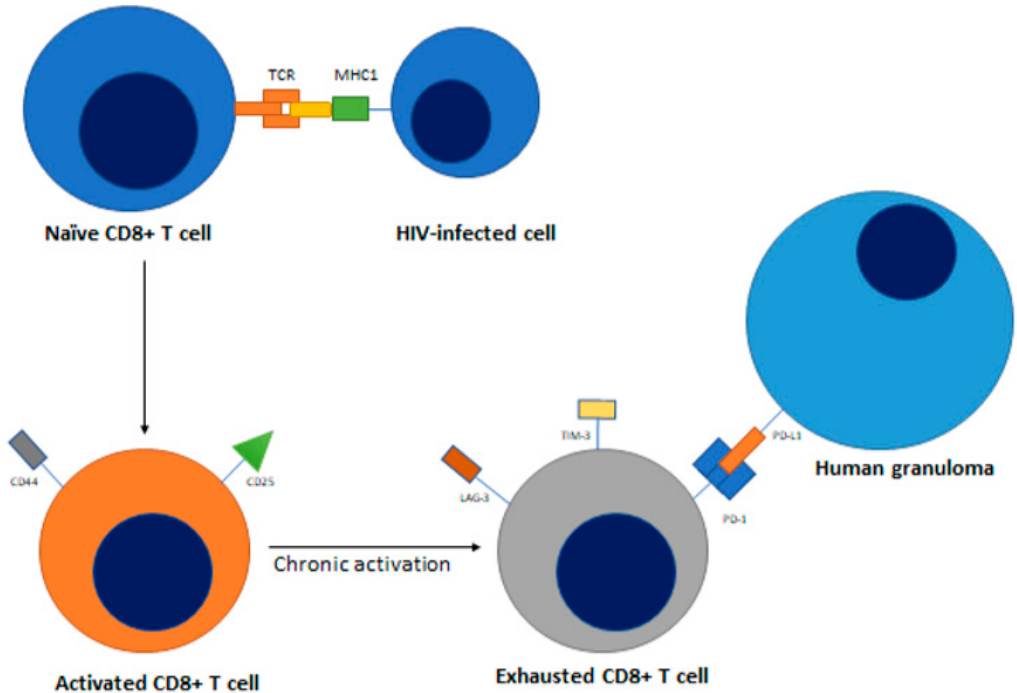
Figure 2. Naïve CD8 + T cells undergo exhaustion after chronic activation by HIV antigen mediated MHC I presentation, with downregulation of activation markers like CD25 and CD44, and upregulation of exhaustion markers like PD-1, LAG-3, and TIM-3. Its activation is also hindered by the PD-1 / PD-L1 interaction with human